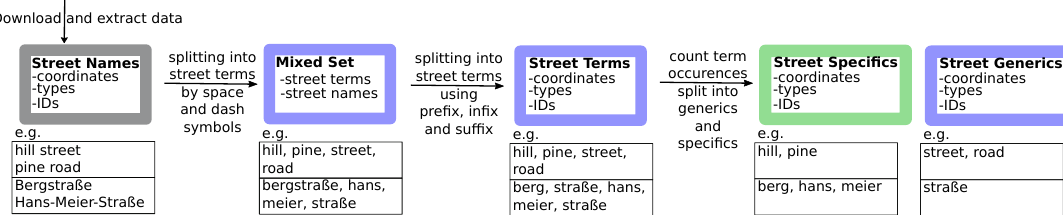
Figure 1. Workflow describing the data extraction and preparation in order to create a set of street specifics and street generics for European and North American countries and states. Street names (grey) are split into specific and generic street terms in a two-step process (middle blue). The lower part of the figure shows examples for English and German street names and how they are split into specific and generic terms. In order to find exact matches, all street names and terms are converted to lower-case symbols. Resulting street specifics (green) will further be used to map street terms to their countries of origin, see also Figure 2. For more details, see description in the text and supplemental data.